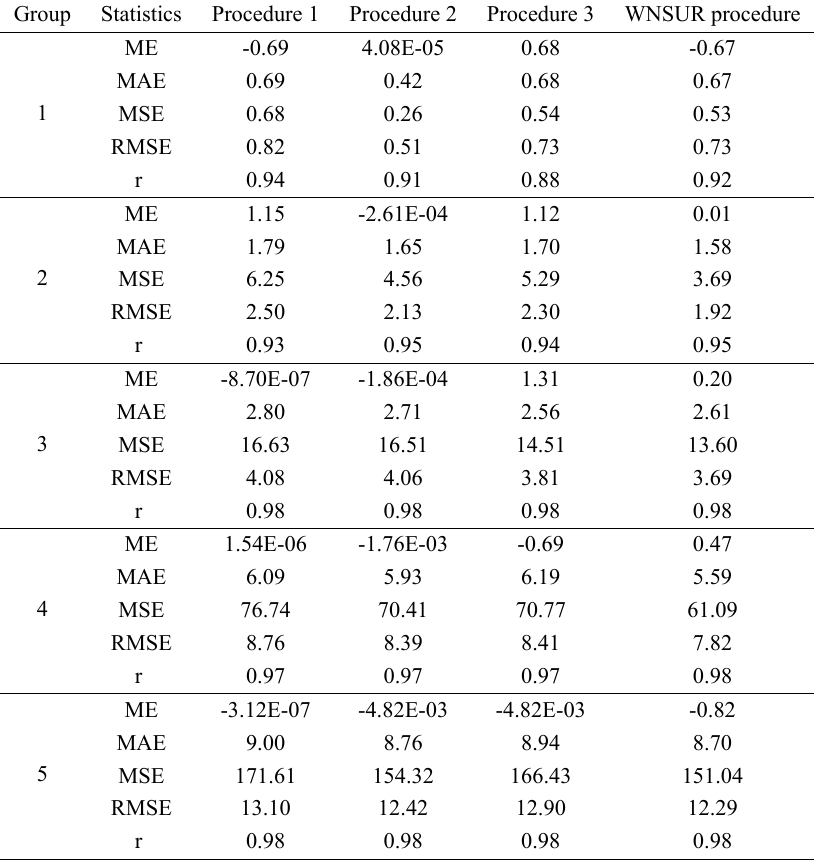
Statistics obtained for comparison the estimates trough ratio and WNSUR procedures of total biomass in stands of black wattle in the state of Rio Grande do Sul, Brazil.